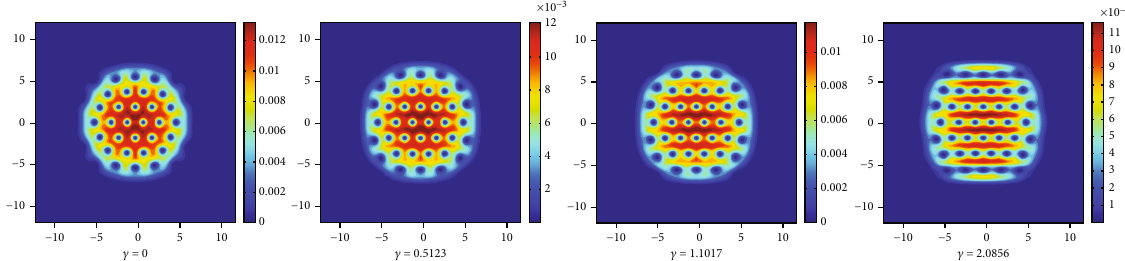
ffiffiffi ffiffiffi p p 5 , n = ð 1,0,1 Þ / 2 ,